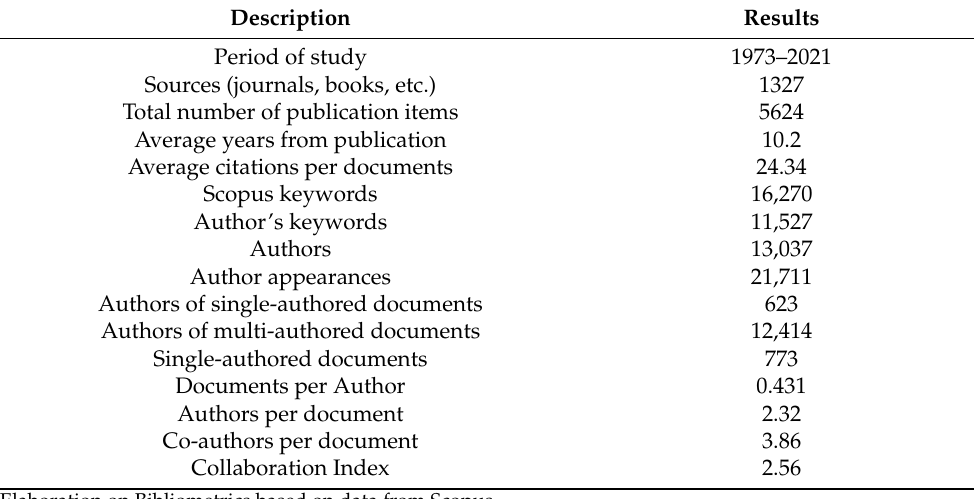
Table 1. Meta information of the database.